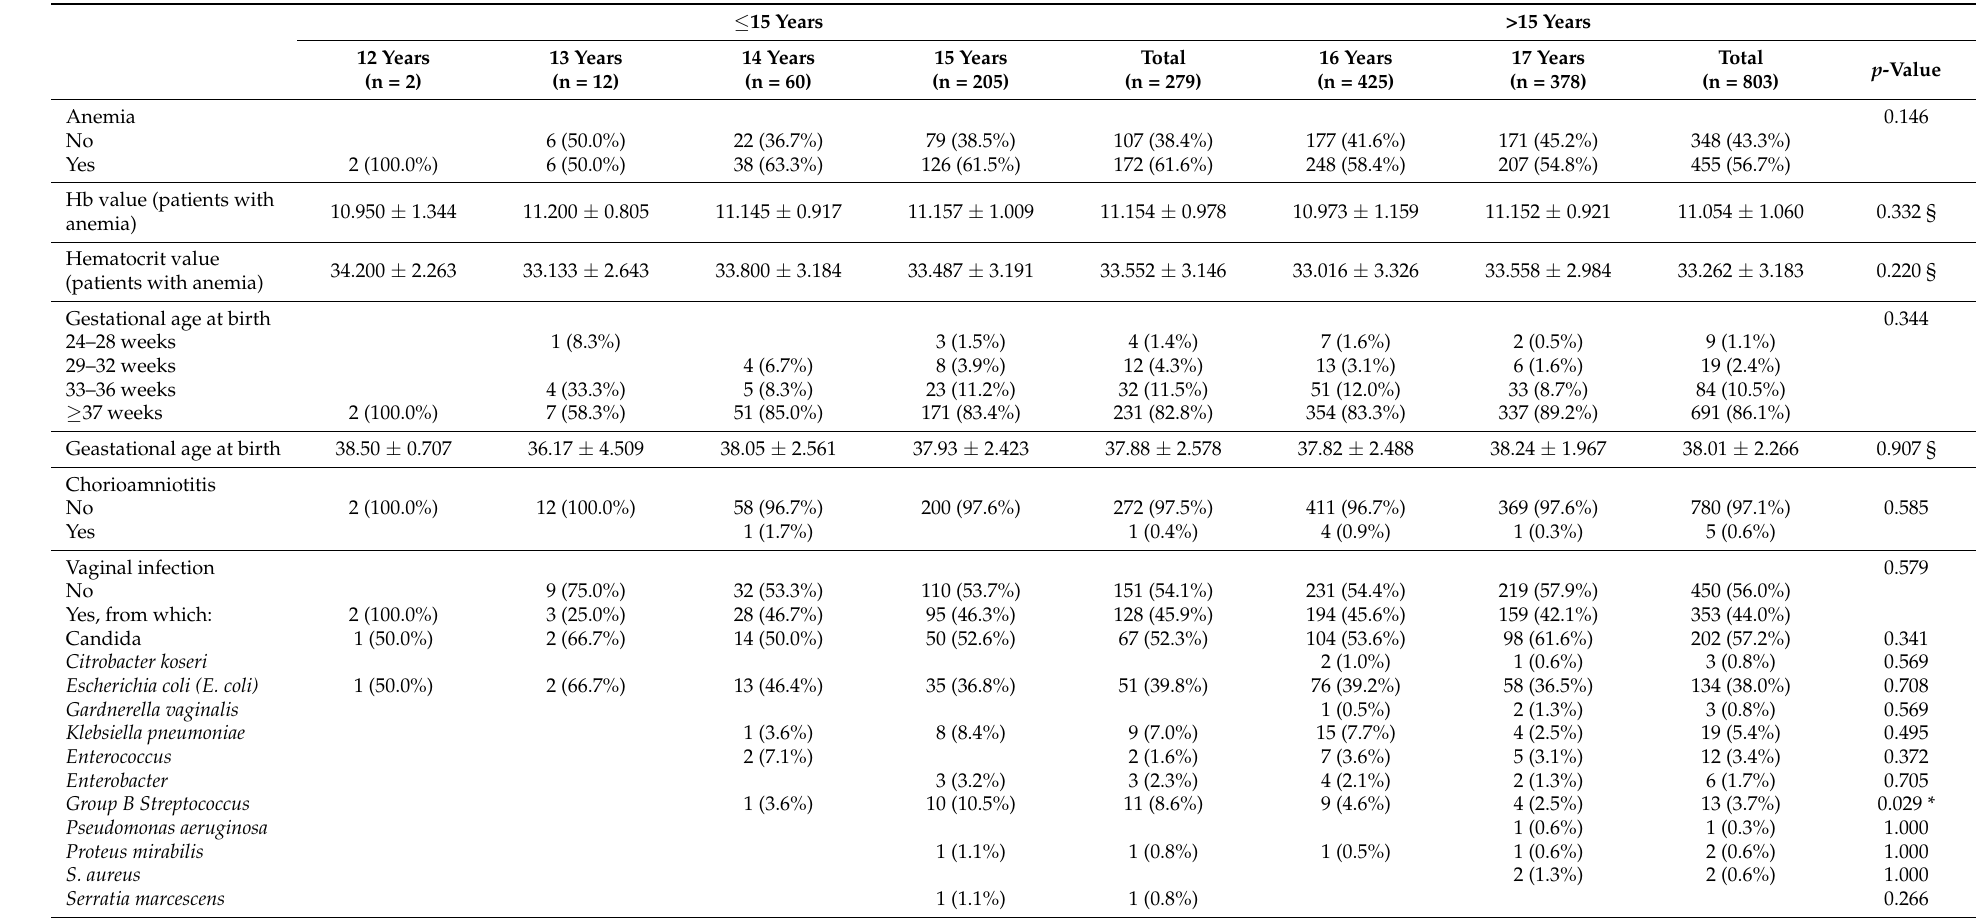
Table 2. Characteristics of pregnant teenagers in our study population (part